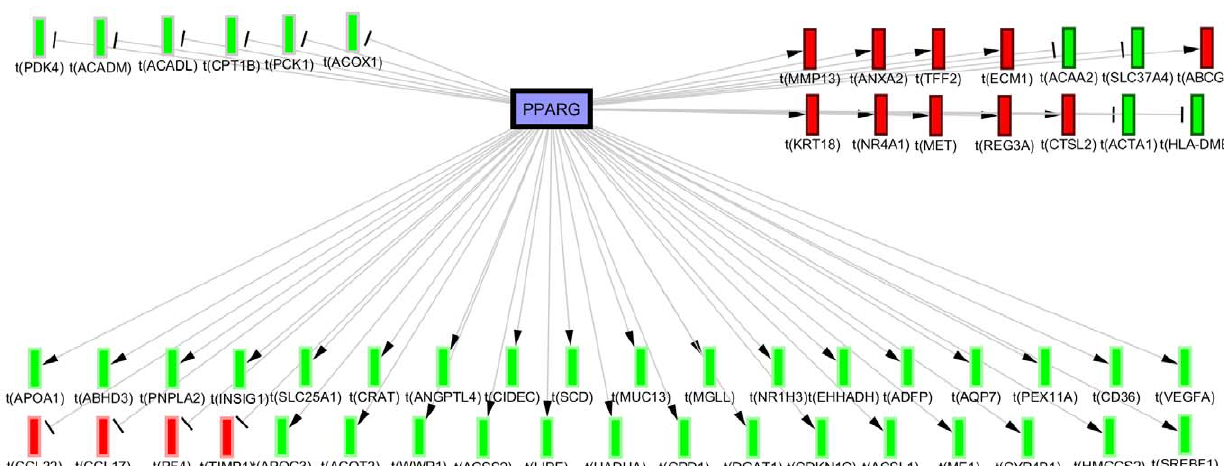
Figure 3. Causal network shows the experimental gene expression changes enriched for the PPARG- hypothesis in the 15 mg/kg group. 36 genes are consistent with the predicted decreased directionality (bottom), 14 are contradictory (top right) and 6 are ambiguous due to contradictory literature (top left). (Blue nodes = predicted decrease, Red nodes = observed mRNA decrease, Green nodes = observed mRNA